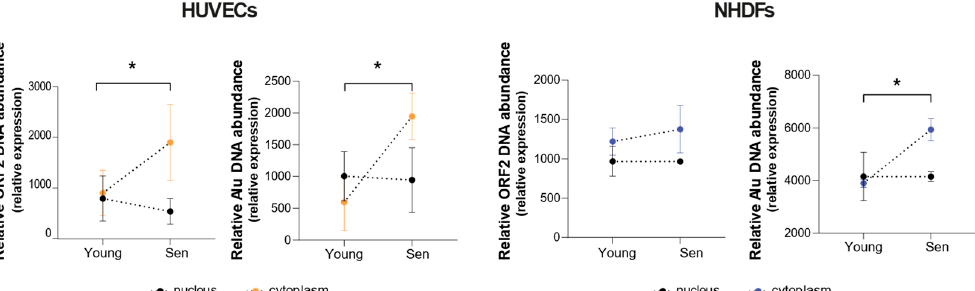
Figure 5. DNA quantification of ORF2 and Alu retrotransposable elements in the cytosolic and nuclear fractions of HUVEC and NHDF cells. * p < 0.05 for two-way ANOVA.